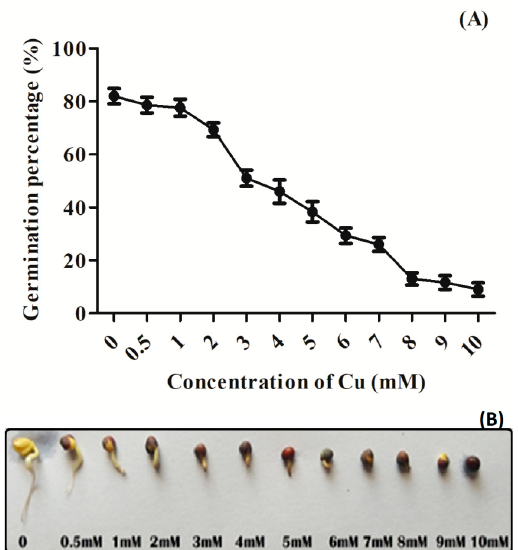
Figure 1. ( A ) Germination percentage; ( B ) phenotype of randomly selected germinating seeds of Indian mustard ( Brassica juncea L.) exposed to copper (Cu) concentrations (0, 0.5, 1, 2, 3, 4, 5, 6, 7, 8, 9 and 10 mM) for 3